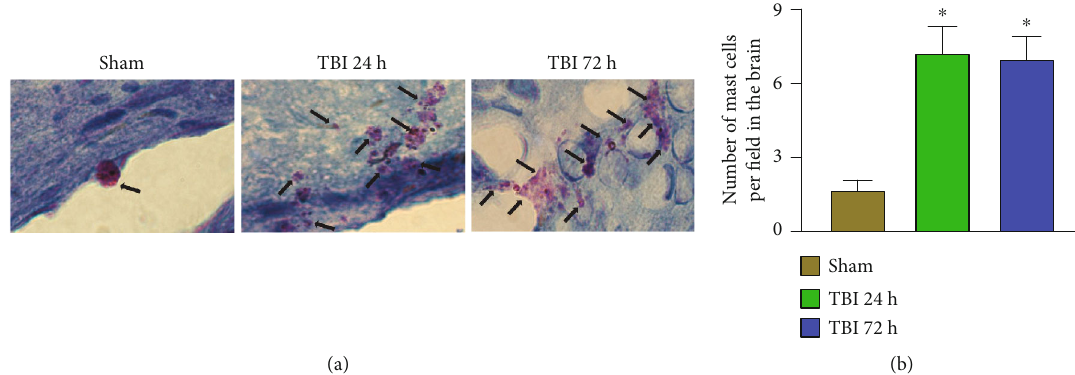
Figure 2: Acute TBI increases mast cell number and degranulation in the brain. Mast cell number and its degranulation were evaluated in the frozen sections (20 μ m) cut from the brains after 24h and 72h of weight drop-induced TBI and sham control mouse brains without TBI ( n = 6 mice/group). These brain sections were stained with 0.1% toluidine blue solution for mast cell detection. The number, as well as activation (purple, black arrows) of mast cells, was increased in 24h and 72h TBI brains as compared with sham control mouse brains without TBI (a). Note the presence of widespread extracellular granules in degranulated mast cells. Degranulated mast cells also appear irregular in shape. Control mast cells without degranulation did not show extracellular cytoplasmic granules. Photomicrograph original magni fi cations =100x. Representative photomicrographs show increased number and activation of mast cells in 24 h and 72h TBI brains as compared with sham control brains without TBI (a). Photomicrograph original magni fi cations=100x. The total number of mast cells was increased in TBI brains as compared to sham control mouse brains (b; ∗ p < 0 : 05 , sham control vs.